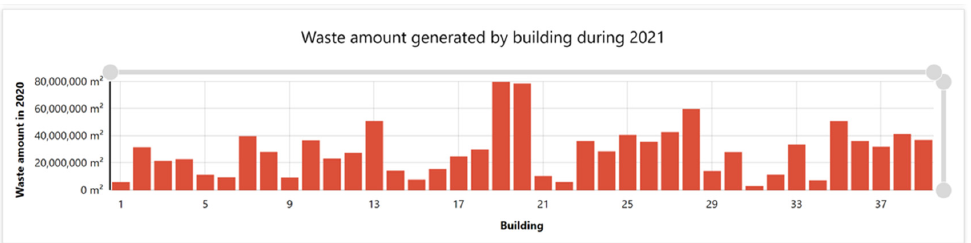
Figure 7 . Indicators of sustainable consumption from waste generation during the year 2021 .